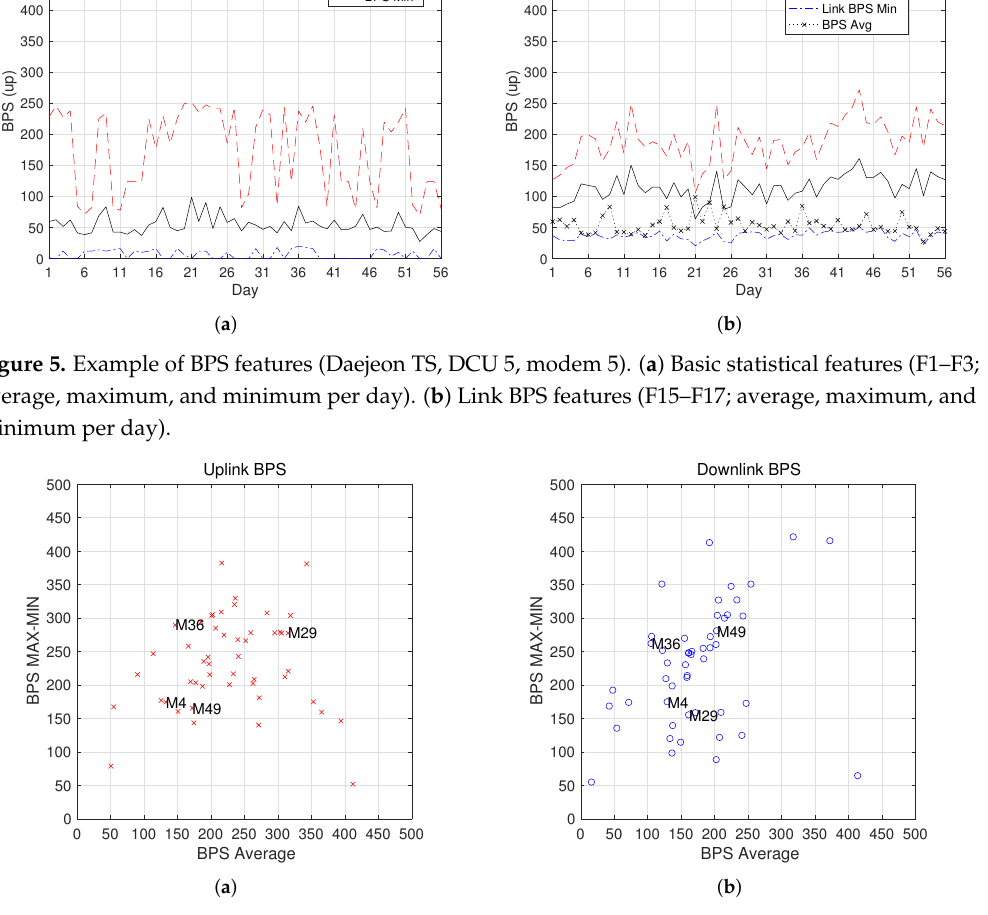
Figure 6. Scatter diagrams of the basic BPS features (F1–F6) for Daejeon TS. ( a ) Uplink of |F1–F3| versus F2. ( b ) Downlink of |F4–F6| versus F5.